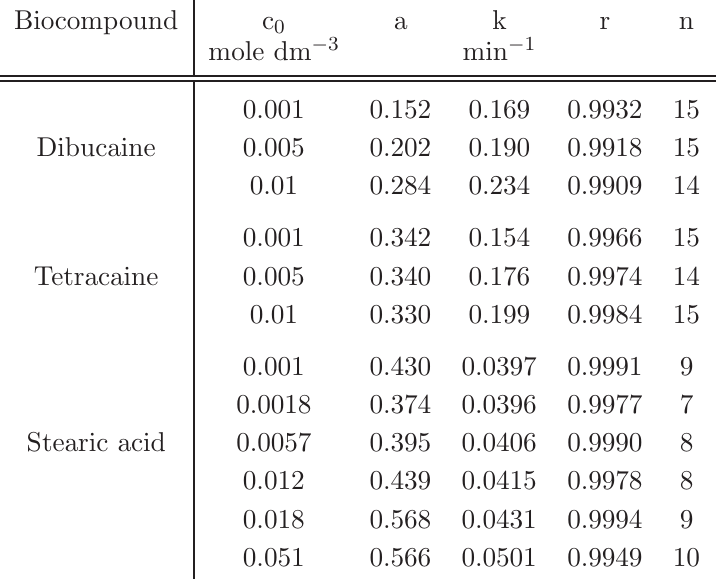
Table 1 The a and k parameters of Eq. (8).